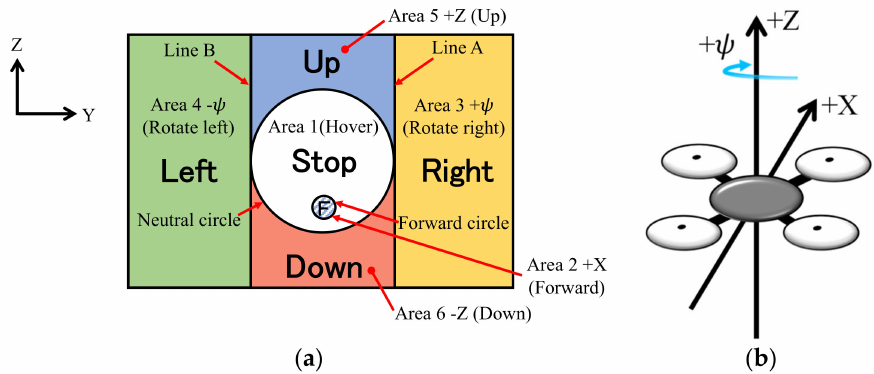
Figure 2. Operation screen and the coordinates around the drone. ( a ) Operation screen and ( b ) Coor- dinate